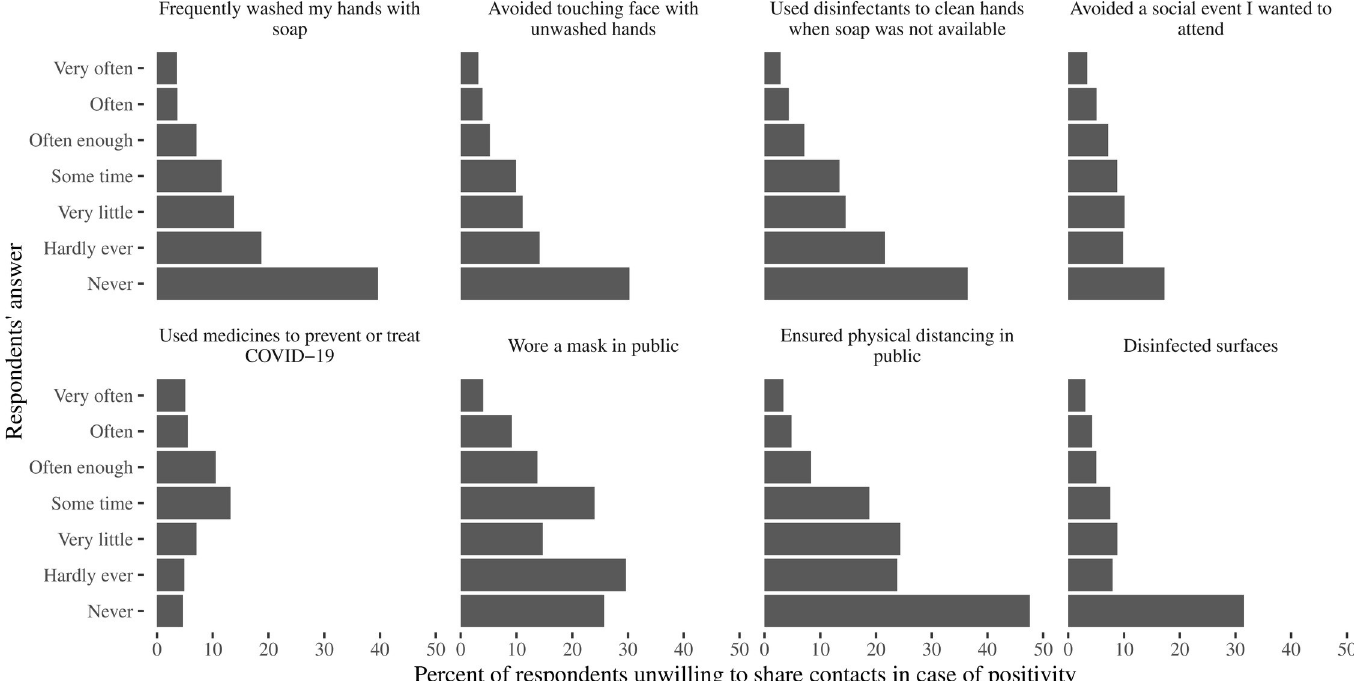
Fig 8. Percent of respondents who expressed unwillingness to share contacts in case of positivity, according to their response to the questions “During the past 7 days, which measures you have performed to prevent to be infected by COVID-19?”. The measures are named at each panel on the figure.